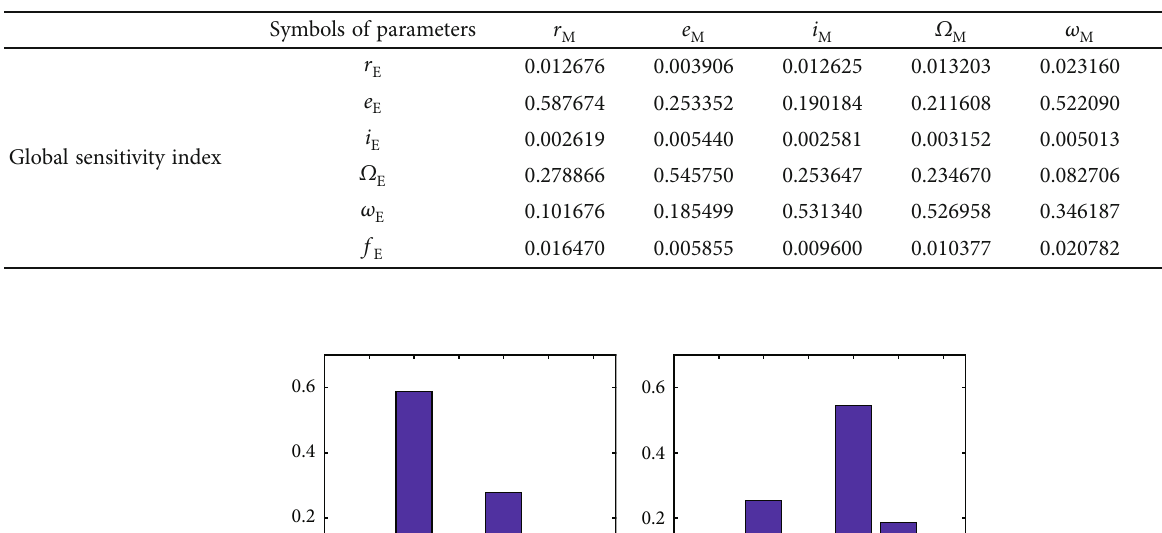
Table 10: Sensitivity index for orbital elements.